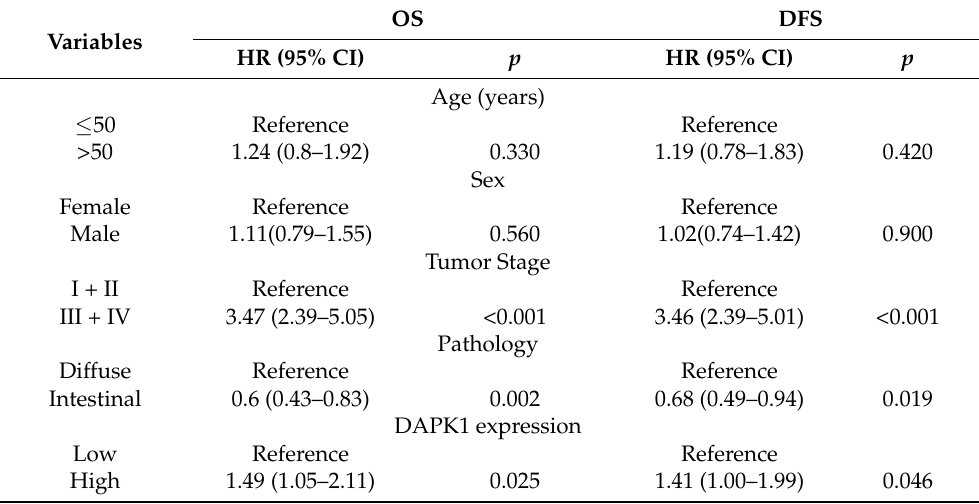
Table 2. A univariate Cox analysis for OS and DFS of GC patients based on the GSE62254 dataset.